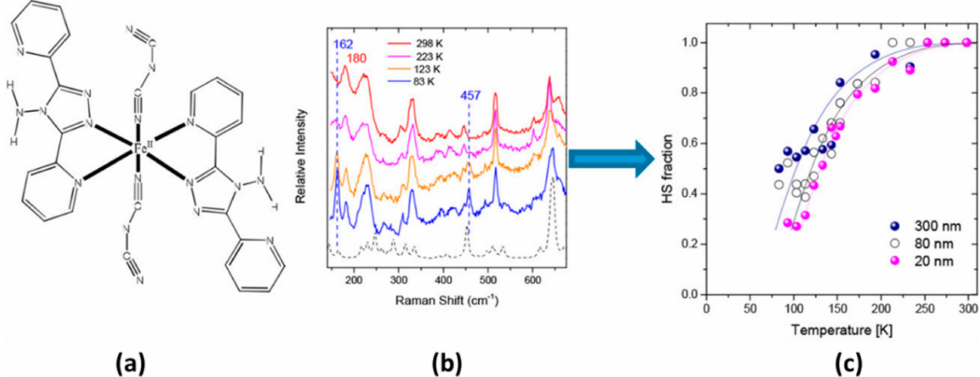
Figure 10. ( a ) Structural drawing of [Fe{N(CN) 2 } 2 (abpt) 2 ] (complex 14 ). ( b ) Raman spectra at the low-frequency region of the complex with particle size of 300 nm at room temperature (red line), 223 K (pink line), 123 K (orange line), and 83 K (blue line); the calculated Raman spectrum of the LS species is presented with a dashed line at 130, 210, and 300 K. ( c ) Temperature dependence of the HS population for complex 14 at samples of different particle sizes (i.e., ~300 nm, ~80 nm, and ~20 nm). The figure is reprinted with permission from ref. [24], copyright 2019, American Chemical